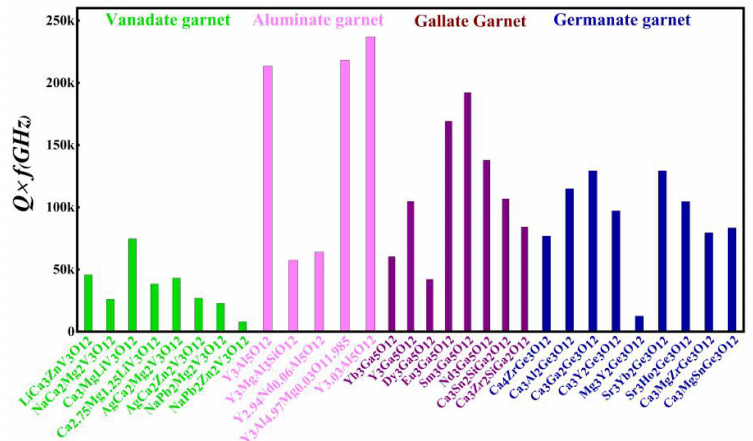
Figure 1. Q × f values of typical garnet-type microwave dielectric